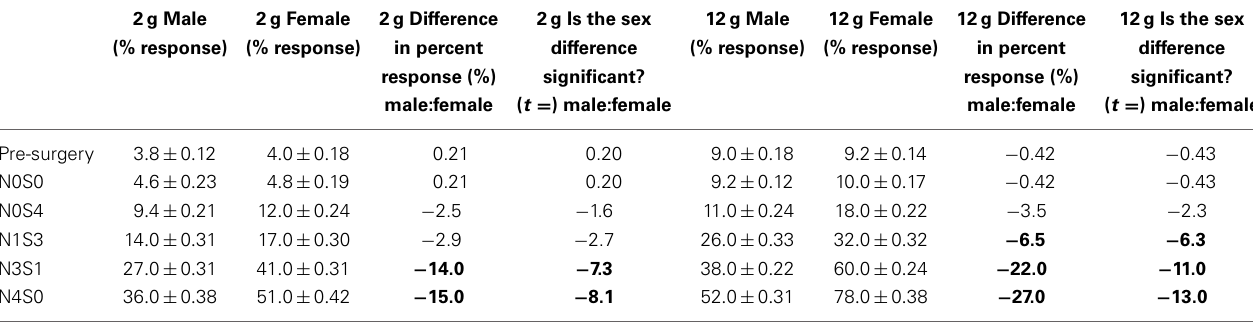
Table 1 | Traditional statistical analysis at independent von Frey Filaments for von Frey Test 2 revealed equivalent male and female baseline (Pre-Surgery)